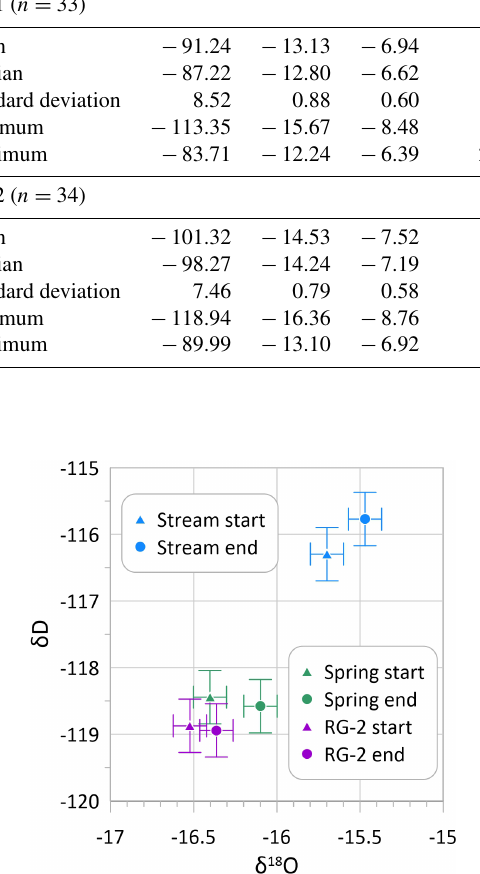
Figure 3. Comparison of isotope values measured for samples from RG-2, the Stream, and the Spring samplers. Subsamples were re- moved from the first sample in early July and the remainder of the water was left inside the collector until early September. Analysis of the sample pairs confirms that potential evaporation-related frac- tionation was minimal.